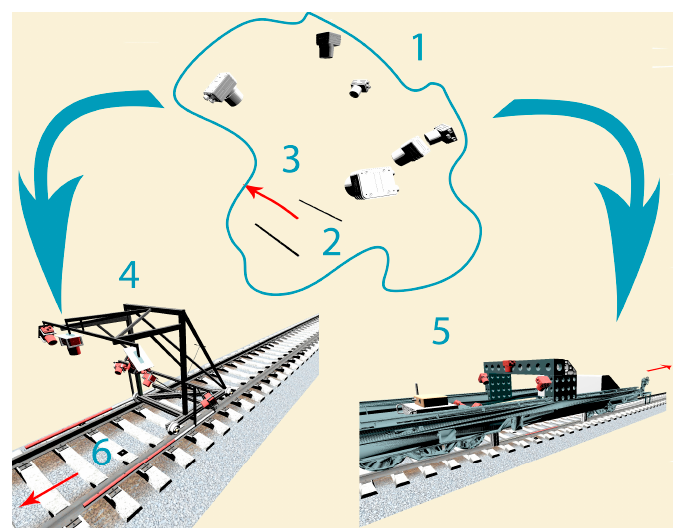
Figure 13. Scheme of proposed image-based method application for railway track inspection. (1) measurement environment (configuration of six cameras and reference template); (2) reference template; (3) arrow shows measurement direction; (4) concept of measuring trolley (TGMT) with implemented method; (5) concept of measuring platform with implemented method; (6) possible placement of control points for geo-localization.